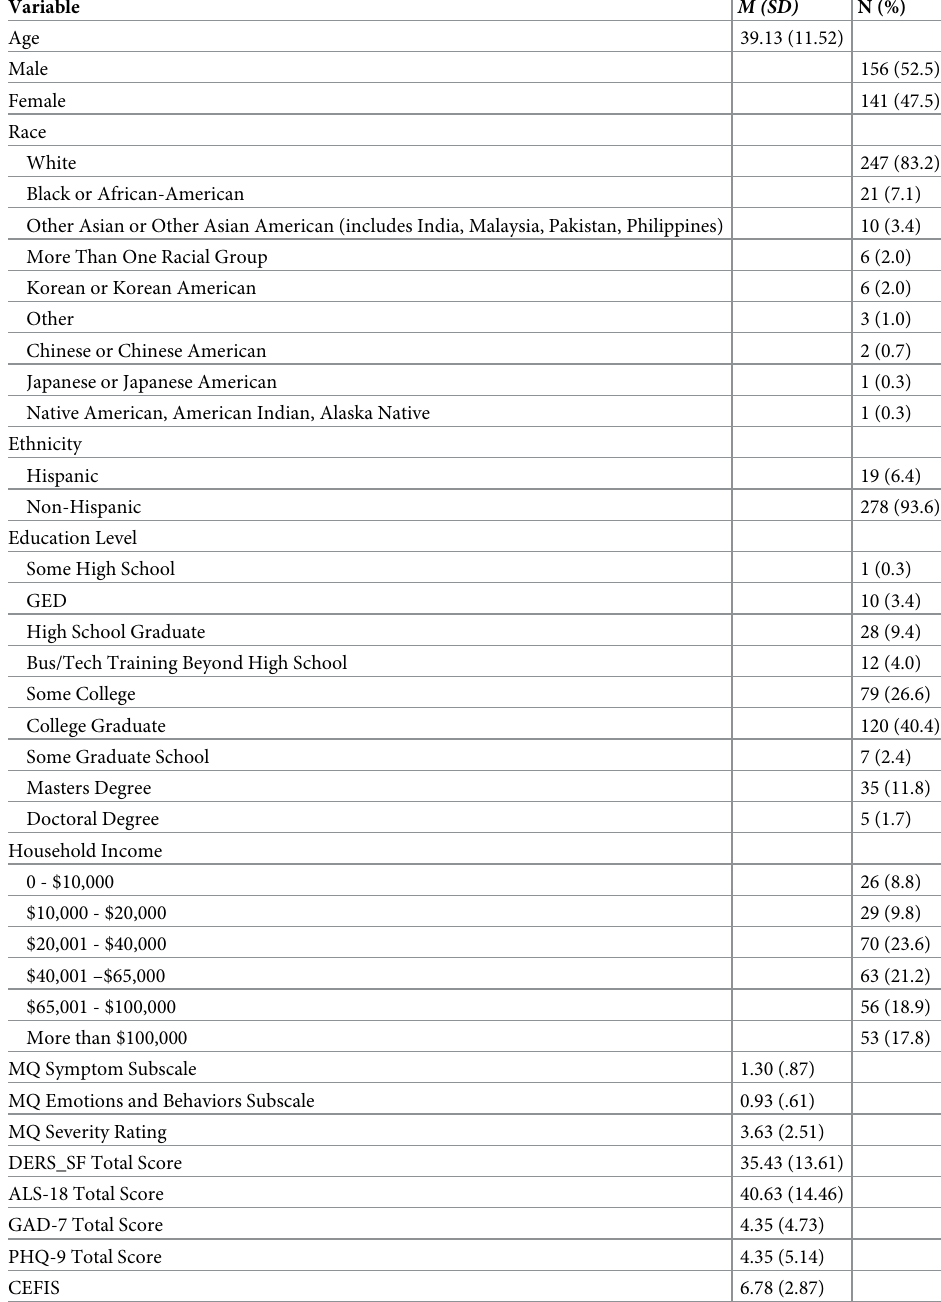
Table 1. Demographics and sample